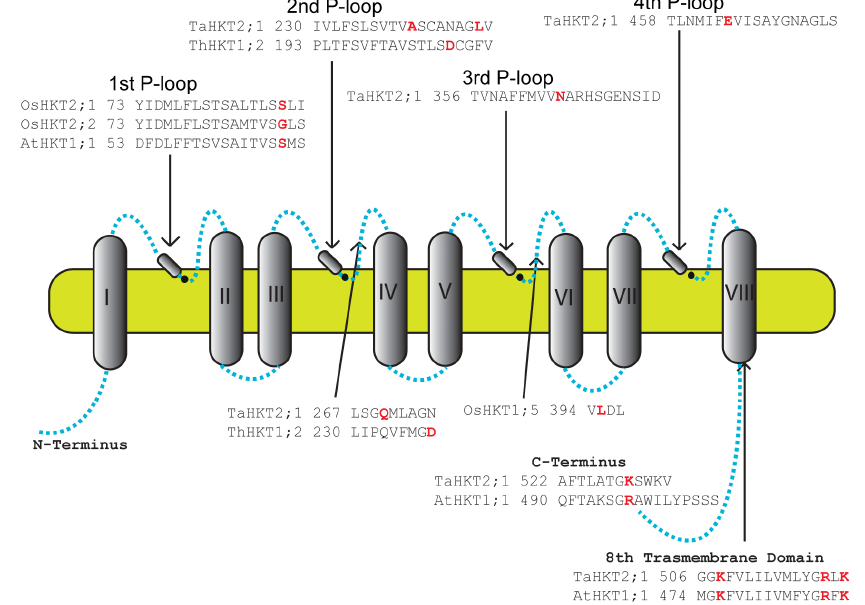
Figure 2. HKT structure and location of specific amino acids that were shown to affect the transport properties when mutated. Alignments show the amino acid sequence of specific domains where these amino acids (highlighted in red ) are present (different plant species) and have been shown to have a crucial role in the correct functioning of the transporter. The function of the highlighted amino acids has been studied by expression of the mutated proteins in heterologous